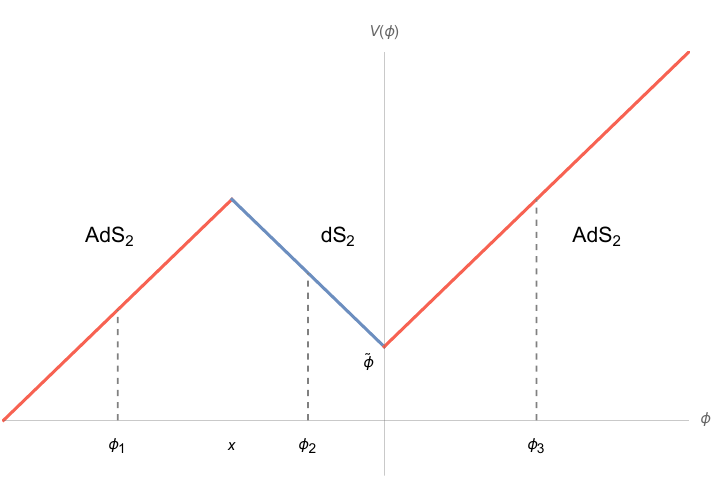
Figure 5 . Plot showing the dilaton potential (5.1) with ˜ φ > 0 . This potential gives an AdS 2 geometry for φ ≤ x and φ ≥ 0 but a dS 2 static patch in the region x ≤ φ ≤ 0 . At a given temperature, there may be up to three candidate black hole